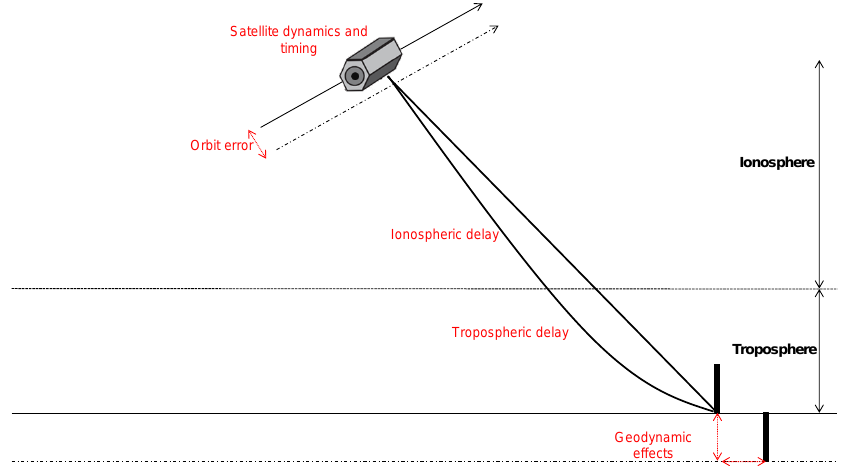
Figure 13. The errors affecting range and azimuth timings of SAR measurements, colorized in red. Orbit errors cause the satellite trajectory to deviate from the true track, while satellite dynamics and atmospheric disturbances cause delays in the timings, which lead to incorrect annotation of τ rg and t az . Geodynamic effects change the position of a target on the ground, which again hampers the accuracy of the timings. Please note that the atmospheric effect shown in the figure is highly exaggerated for visualization purposes only. The main cause for atmospheric delay is the decrease of the speed of